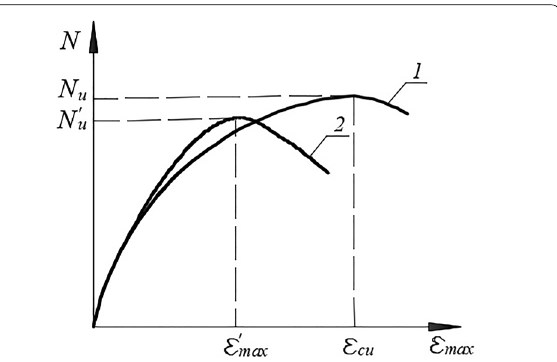
Fig. 5 Dependences of the compressive force from deformation of the most compressed fibre of concrete core: 1—with full implementation of strength properties of the concrete core; 2—for the cases when the strength properties of the concrete are not realized